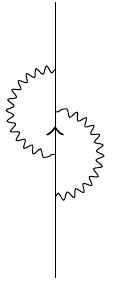
Figure 7 . Feynman diagram corresponding to the contribution of C 1 ; 1 (4) in m 1 (2) . The corre- sponding ribbon graph shown in figure